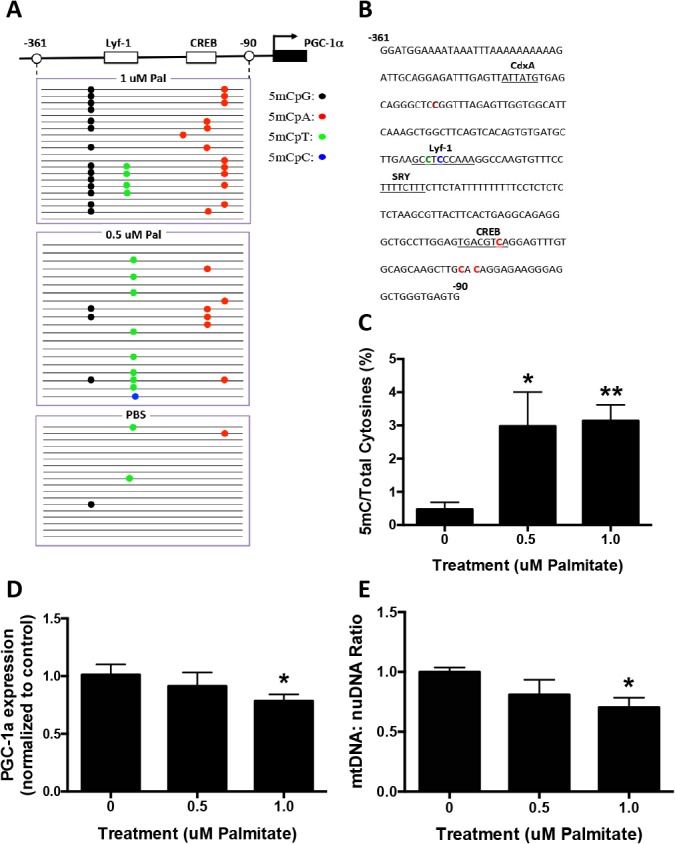
Palmitate induces PGC−1α promoter methylation in human mutant α−synuclein transgenic mice (DMSYN).Infusion pumps were implanted with a cannula aiming into the right lateral ventricle. 100uL of solution (PBS, 0.5 uM Pal or 1 uM Pal) were consistently delivered to the brain at a flow rate of 0.25uL/h for 14 days. A. Graphic representation of the bisulfite-sequenced portion (-361 to -90) of the PGC−1α promoter and visualization of bisulfite sequencing results as analyzed by MethTools 3.0. The transcription start site (arrow) and first exon (black box) are shown. B. Methylation sequencing region in the PGC−1α promoter. Important transcription factors are underlined. Methylated CpGs are highlighted in brown, CpAs in red, CpTs in green and CpCs in blue. C. Quantitation of cytosine methylation levels of the PGC−1α gene. Methylation of the PGC−1α promoter was increased by 630.1% with the treatment of 0.5 uM palmitate (p = 0.0294) and by 664.3% with the treatment of 1 uM palmitate (p<0.0001) compared to PBS control. D. Quantification of PGC−1α mRNA by qRT-PCR revealed a 21.7% decrease with the treatment of 1.0 uM palmitate (p = 0.038) compared with PBS controls. E. Quantitation of the mitochondria DNA (mtDNA) to nuclear DNA (nuDNA) ratio using real-time PCR. mtDNA:nuDNA ratio was decreased by 30.2% in 1.0 uM palmitate treatment compared to control (p = 0.02). Results were presented as mean±SEM, *p<0.05, **<0.01, ANOVA with Student-Newman-Keuls post hoc analysis.